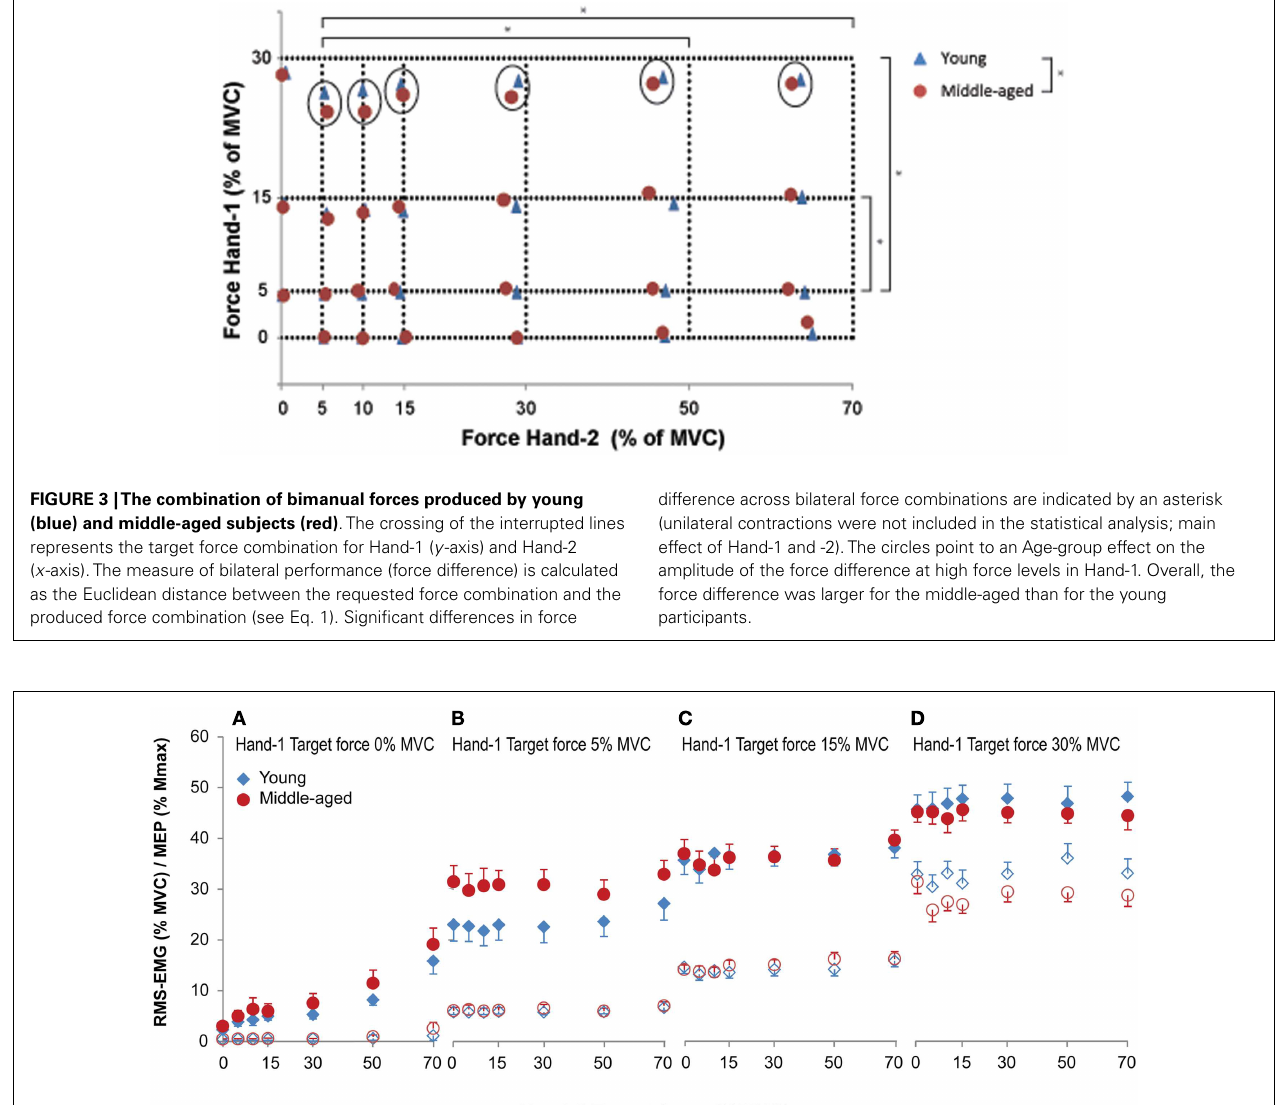
FIGURE 4 | Mean and standard error of RMS-EMG (100ms, open symbols, bottom row) and MEPs (closed symbols, top row) during unilateral (A) and bilateral (B–D) forces at different force combinations for young (blue) and middle-aged (red) subjects. Hand-1 is the hand in which the MEPs in the FDI were evoked and the hand that started the contraction during the bilateral contractions. For the values presented in (A) and the unilateral contractions (force Hand-2 equals 0) in (B–D) all MEPs were included for calculating the